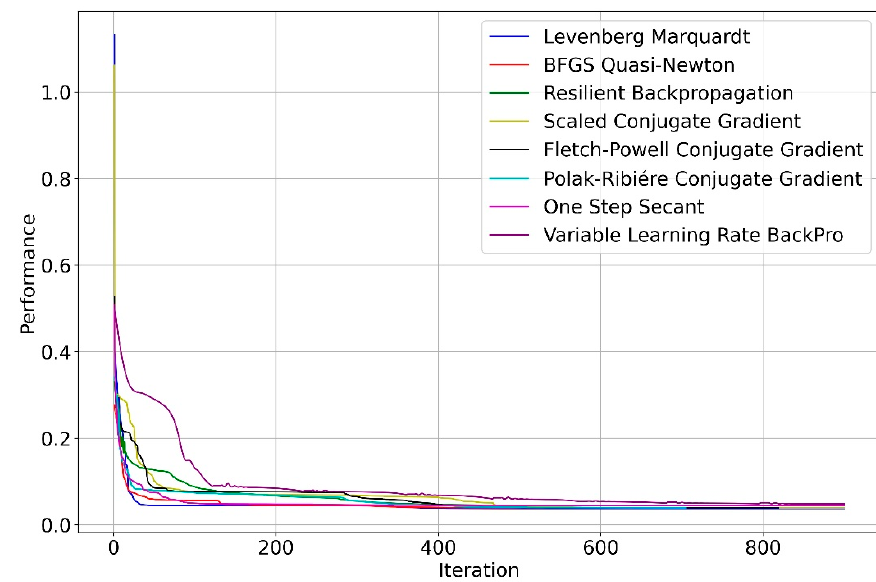
Figure 3 . Convergence of the 8 algorithms used in the training of the (4,2,2,1) architecture. Figure 3. Convergence of the 8 algorithms used in the training of the (4,2,2,1)